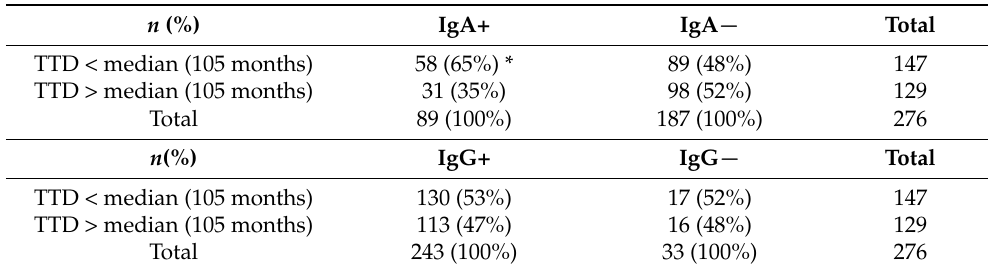
Table 2. Association of anti-HLA IgA and IgG status and early 1 time-to-dialysis (TTD) in 276 patients with allograft failure.